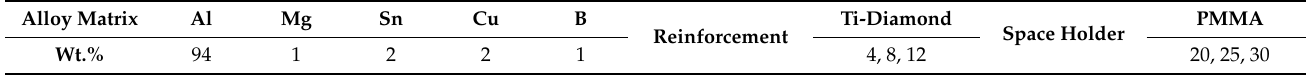
Table 1. Composition of Ti-coated diamond reinforced porous Al composites.